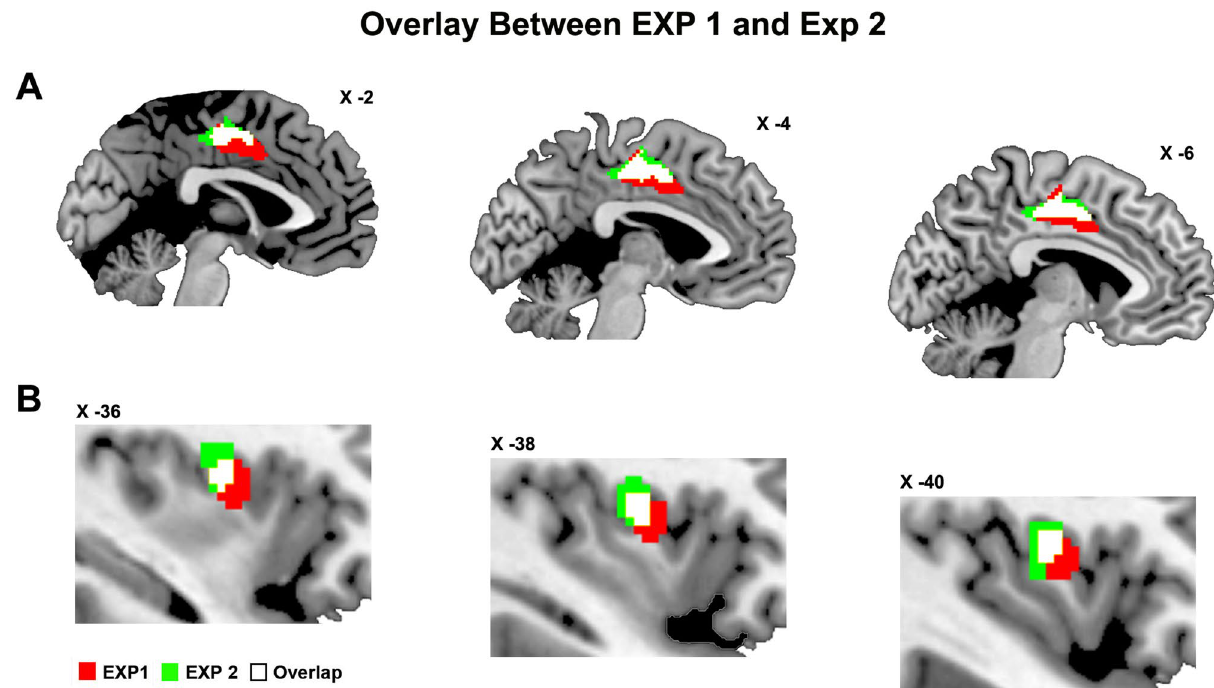
obtained in situation 1 (handshake and facial expression), and namely, the sector of the left cingulate cortex ( A ) and the left dorso-central insula ( B ). Red color indicates areas resulting from the conjunction analysis carried out in Exp. 1 between the contrasts aggressive vs. neutral and gentle vs. neutral while green color indicates areas found activated in Exp. 2 during the angry context. White color indicates the overlap area. These brain activations are rendered using a standard Montreal Neurological Institute brain template (P FWE <